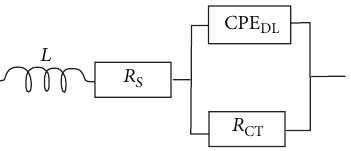
Figure 1: Equivalent circuit used to fit the impedance